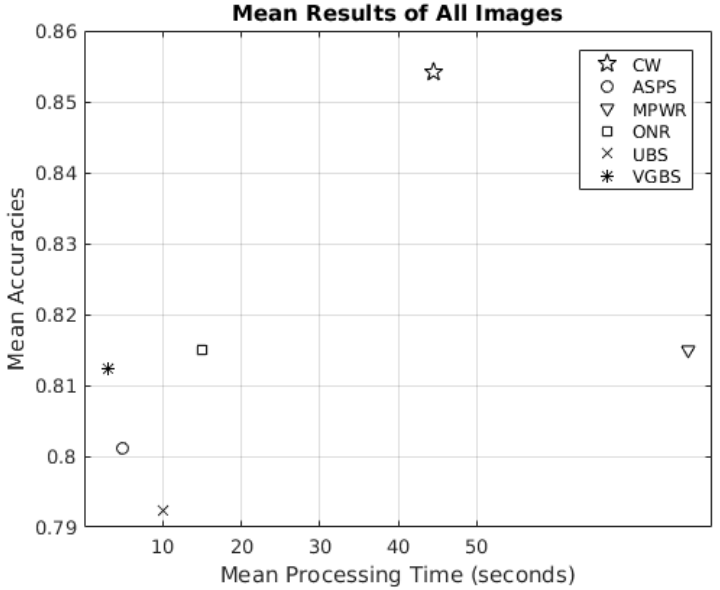
Figure 10. Mean processing time of all images and all classifiers